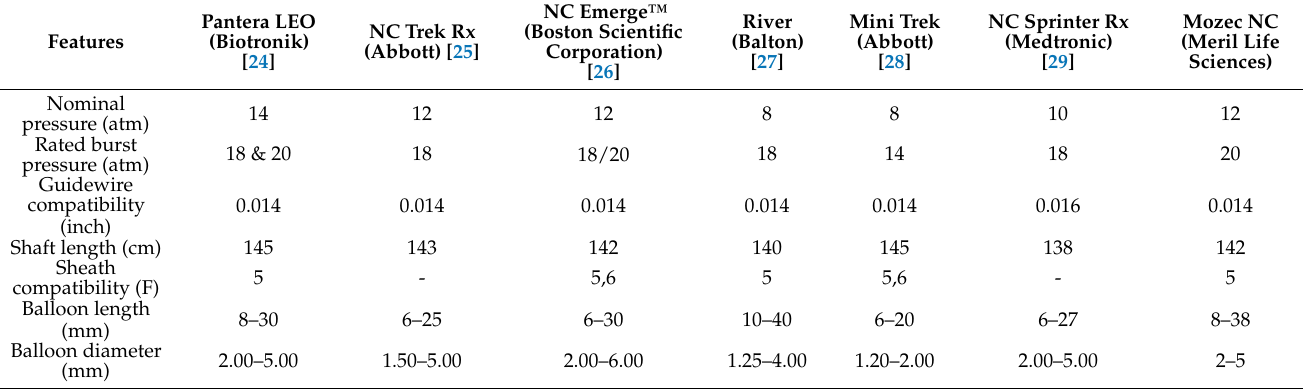
Table 4. Technical comparison of contemporary non-compliant balloon dilatation